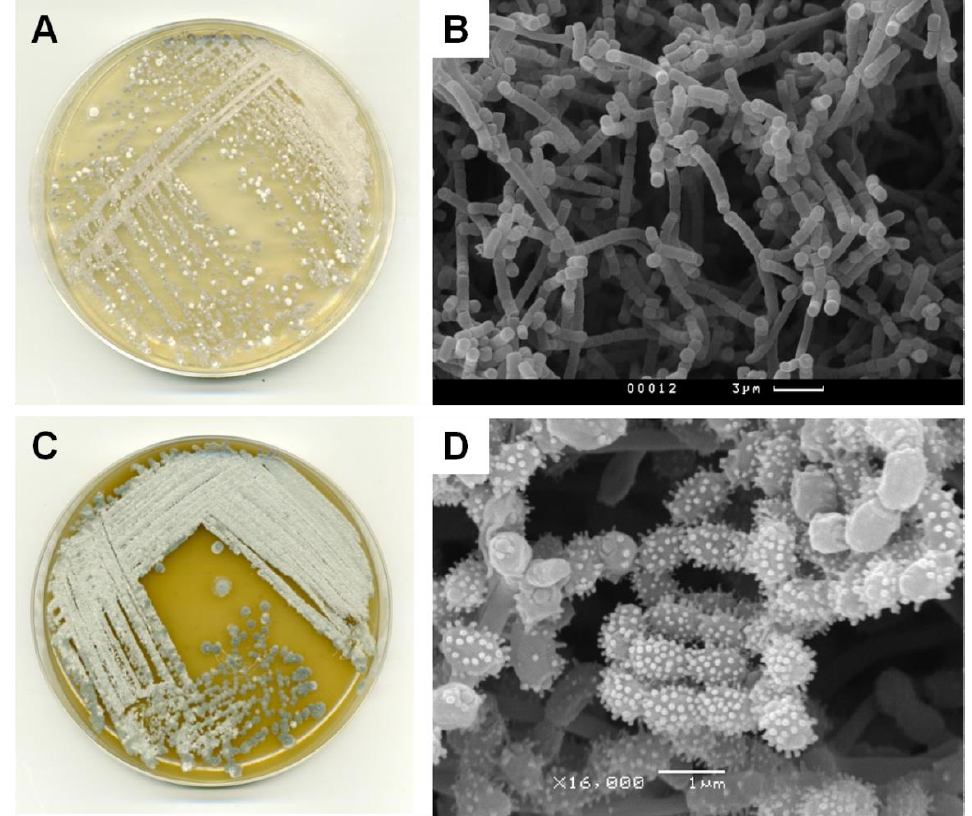
Figure 5. Morphological properties of Streptomyces sp. KB-1, grown on ISP4 medium at 28 °C for 14 days ( A , B ), and Streptomyces sp. BV113, grown on ISP3 medium at 28 °C for 14 days ( C , D ). ( A , C ) Photographs of plates with strain streaks. ( B , D ) Mycelium micrographs taken on a scanning electron microscope (SEM).